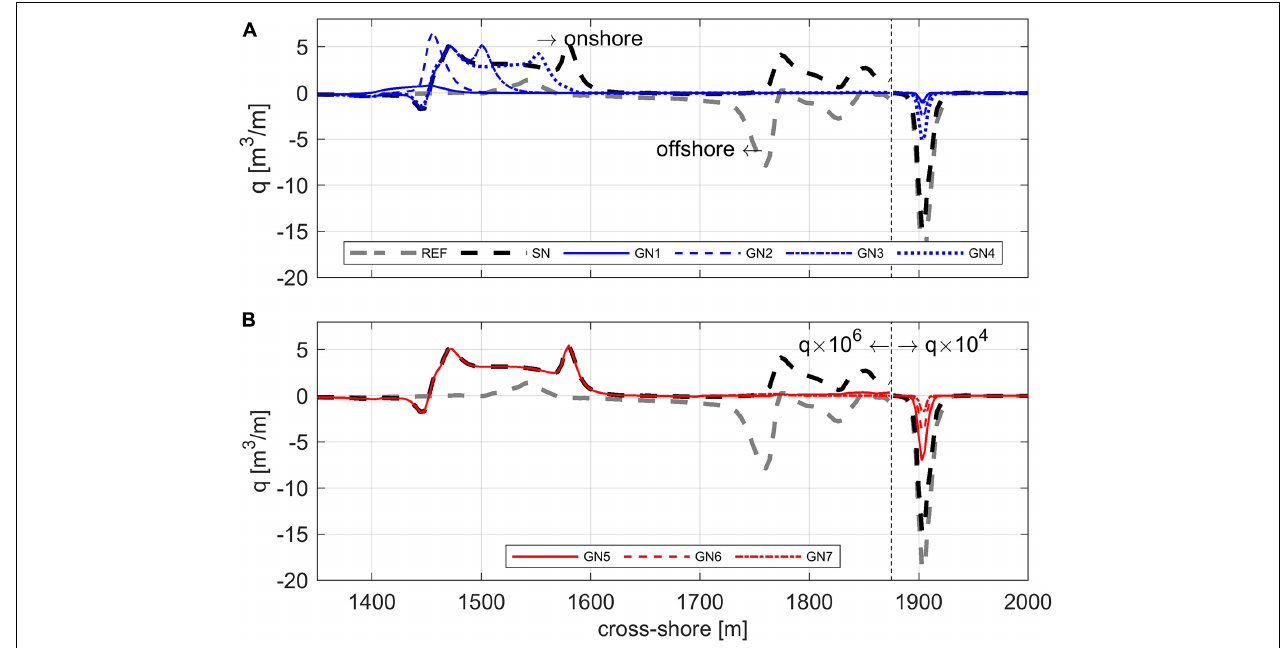
FIGURE 6 | Cross-shore sediment flux for: (A) case REF, SN, and GN1-4; and (B) case GN5-7. Note that the value was amplified for illustration purpose with a factor of 10 6 and 10 4 in seaward and shoreward of x = 1,875 m, respectively. Positive and negative value indicates onshore and offshore directed sediment flux.